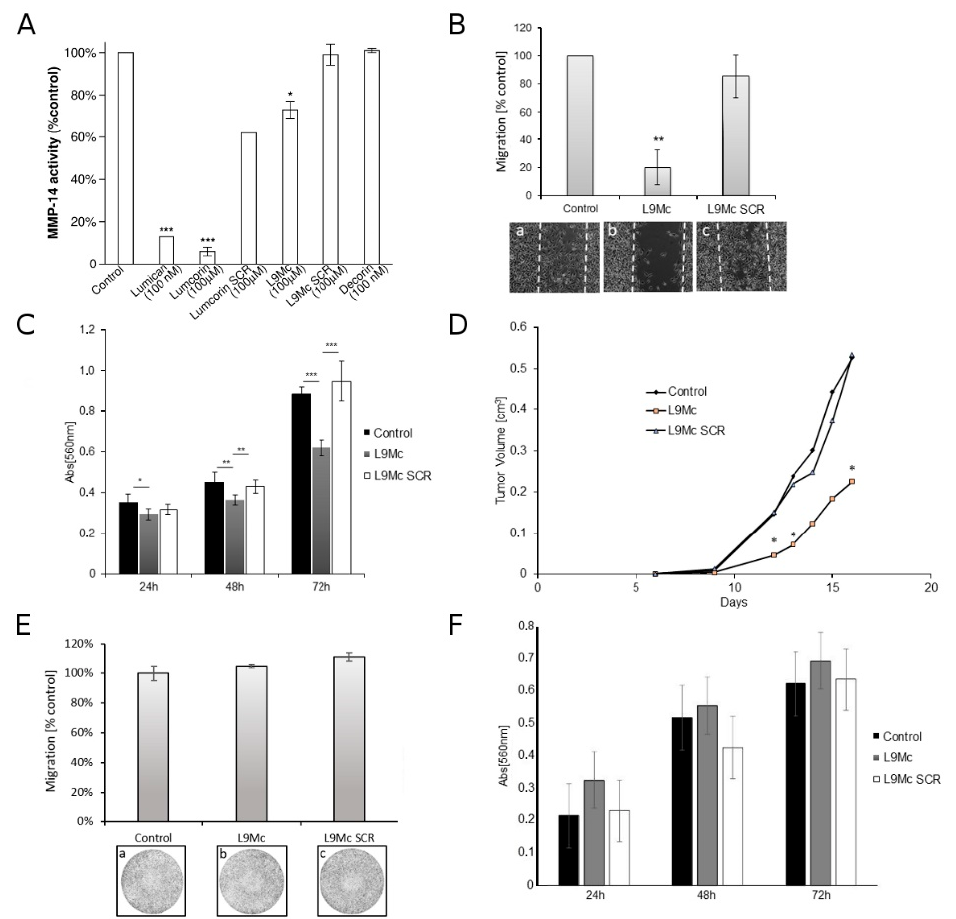
Figure 6. Effect of L9Mc on MMP-14 activity, melanoma cell migration, proliferation, and primary tumor growth. ( A ) MMP-14 assay. Comparison of the effects of lumican, lumcorin and its scrambled (SCR) peptide, L9Mc and its scrambled (SCR) peptide, and decorin on MMP-14 activity measured using the fluorimetric SensoLyte R 520 MMP-14 assay kit as described in the Materials and Methods. Recombinant human MMP-14 was preincubated overnight with 100 nM lumican or 100 µ M lumcorin or L9Mc peptide. Data are presented as mean values ± SD from three independent experiments. ( B ) Migration of B16F1 murine melanoma cells in the presence of L9Mc peptide or its control.